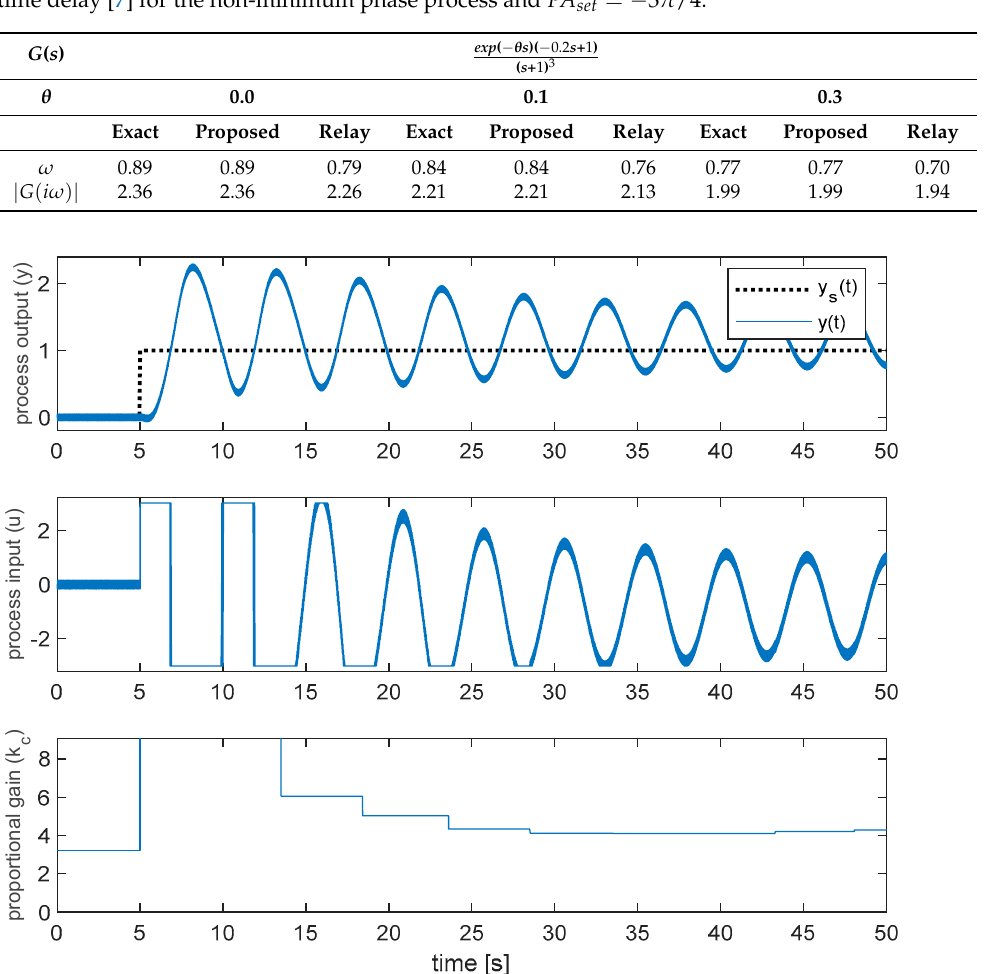
Table 6. Estimates of the proposed method and the relay feedback method [1] combined with the time delay [7] for the non-minimum phase process and PA set = − 3 π /4.